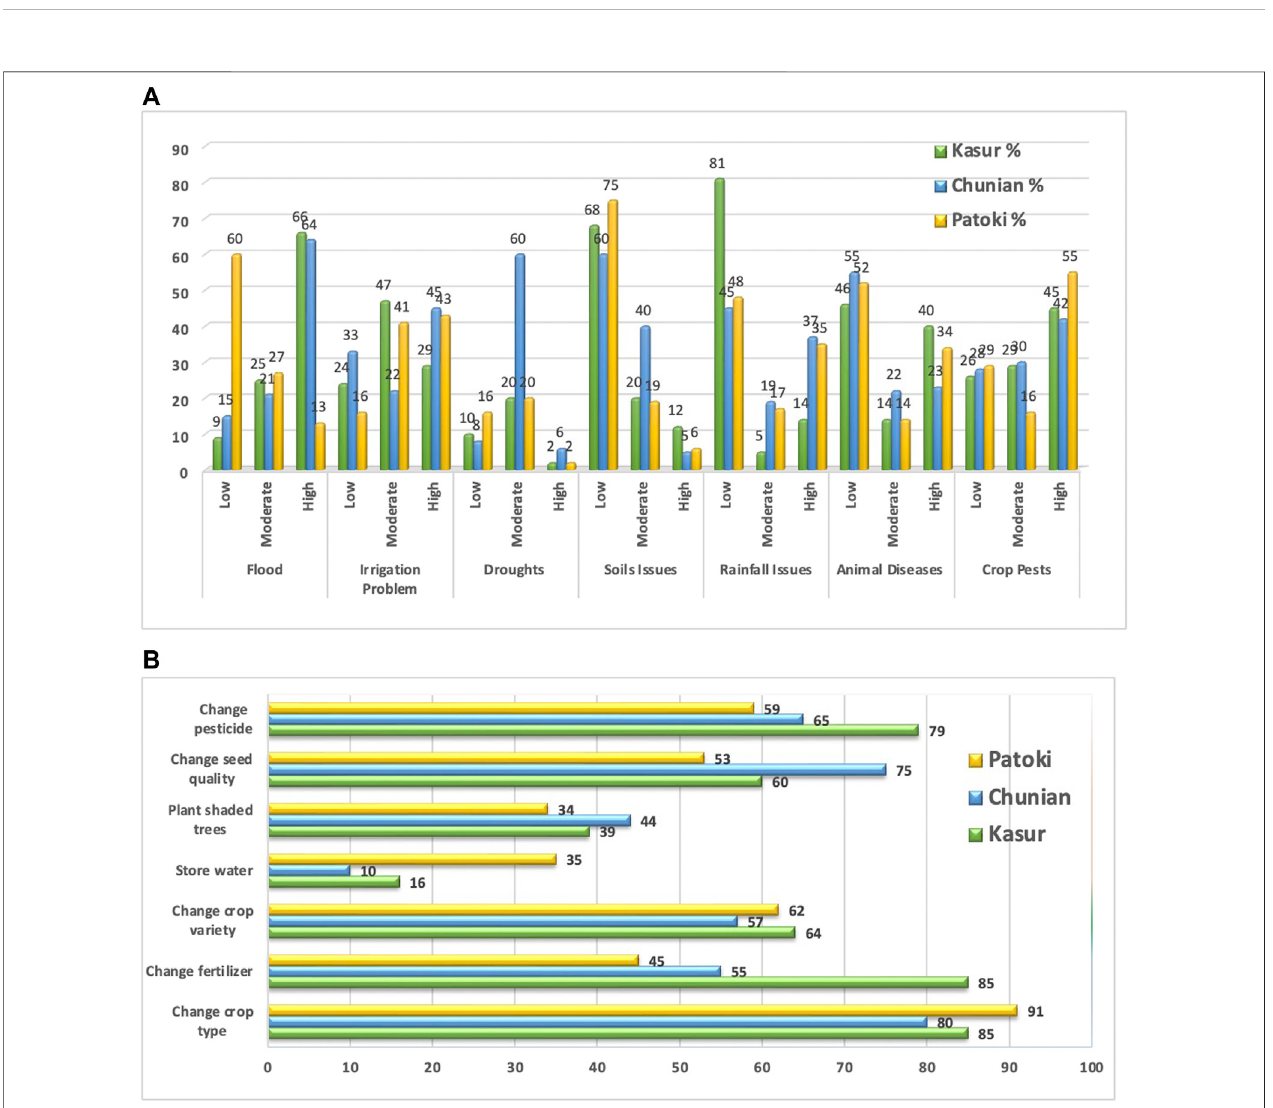
FIGURE 2 | (A) Agricultural Communities ’ Determining factor of Climate Change (%) (B) : Adaption strategies/measures (%) by Agricultural Communities ’ .